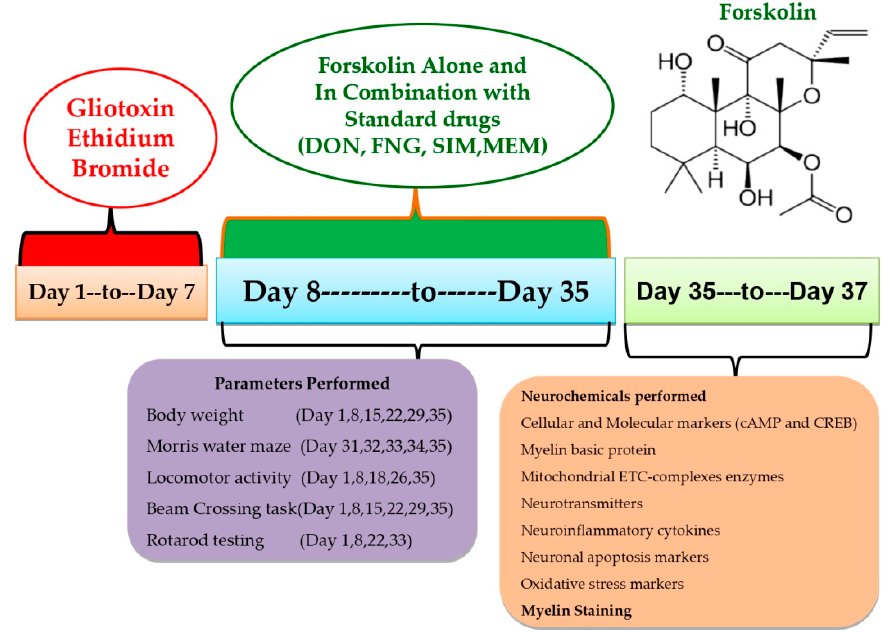
Figure 1. Estimation of behavioral and neurochemical parameters.